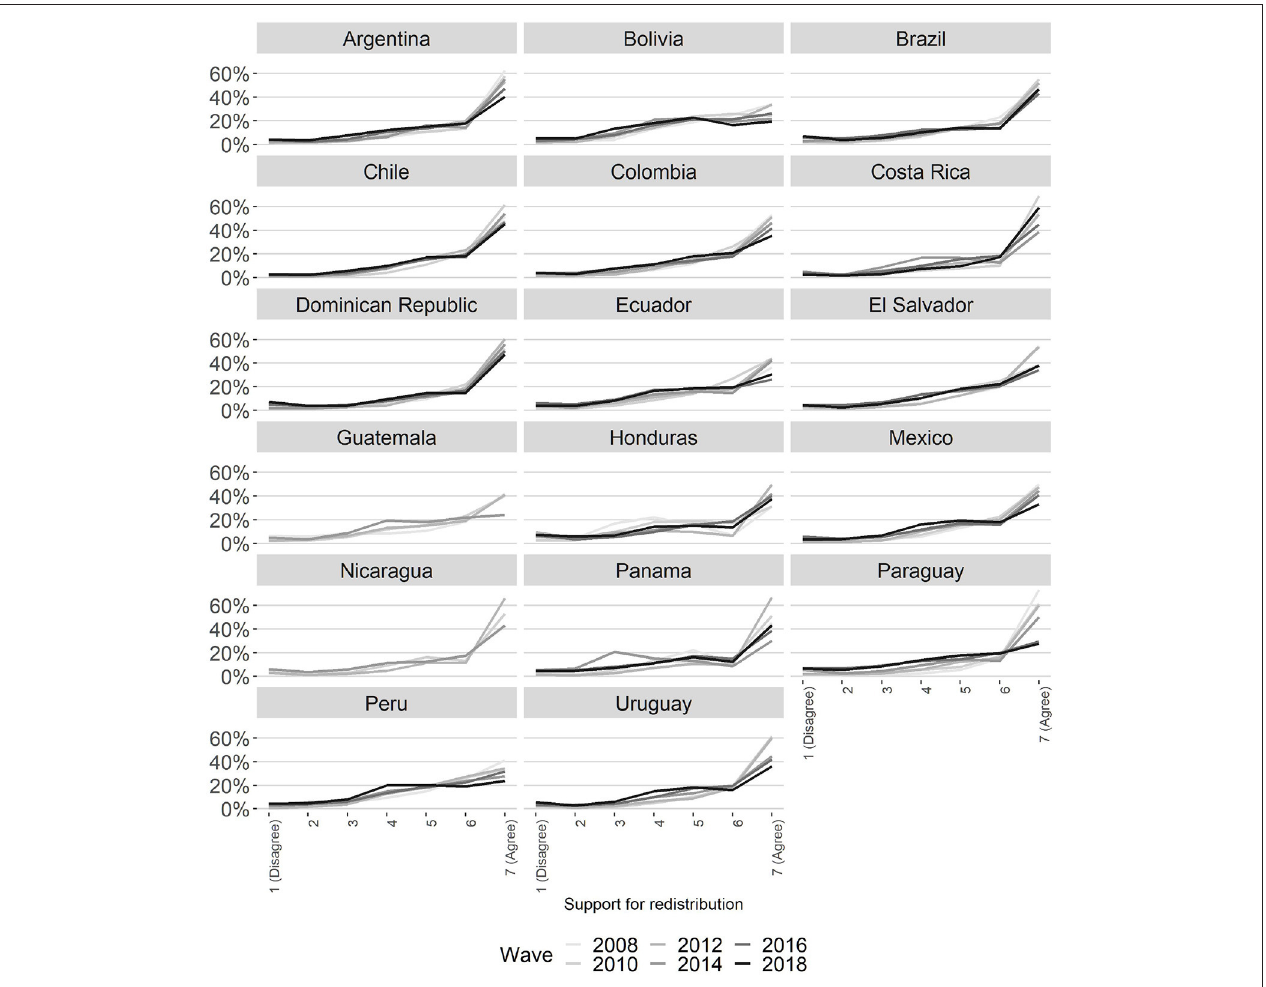
FIGURE 3 | Support for redistribution by country and year. Percentage by